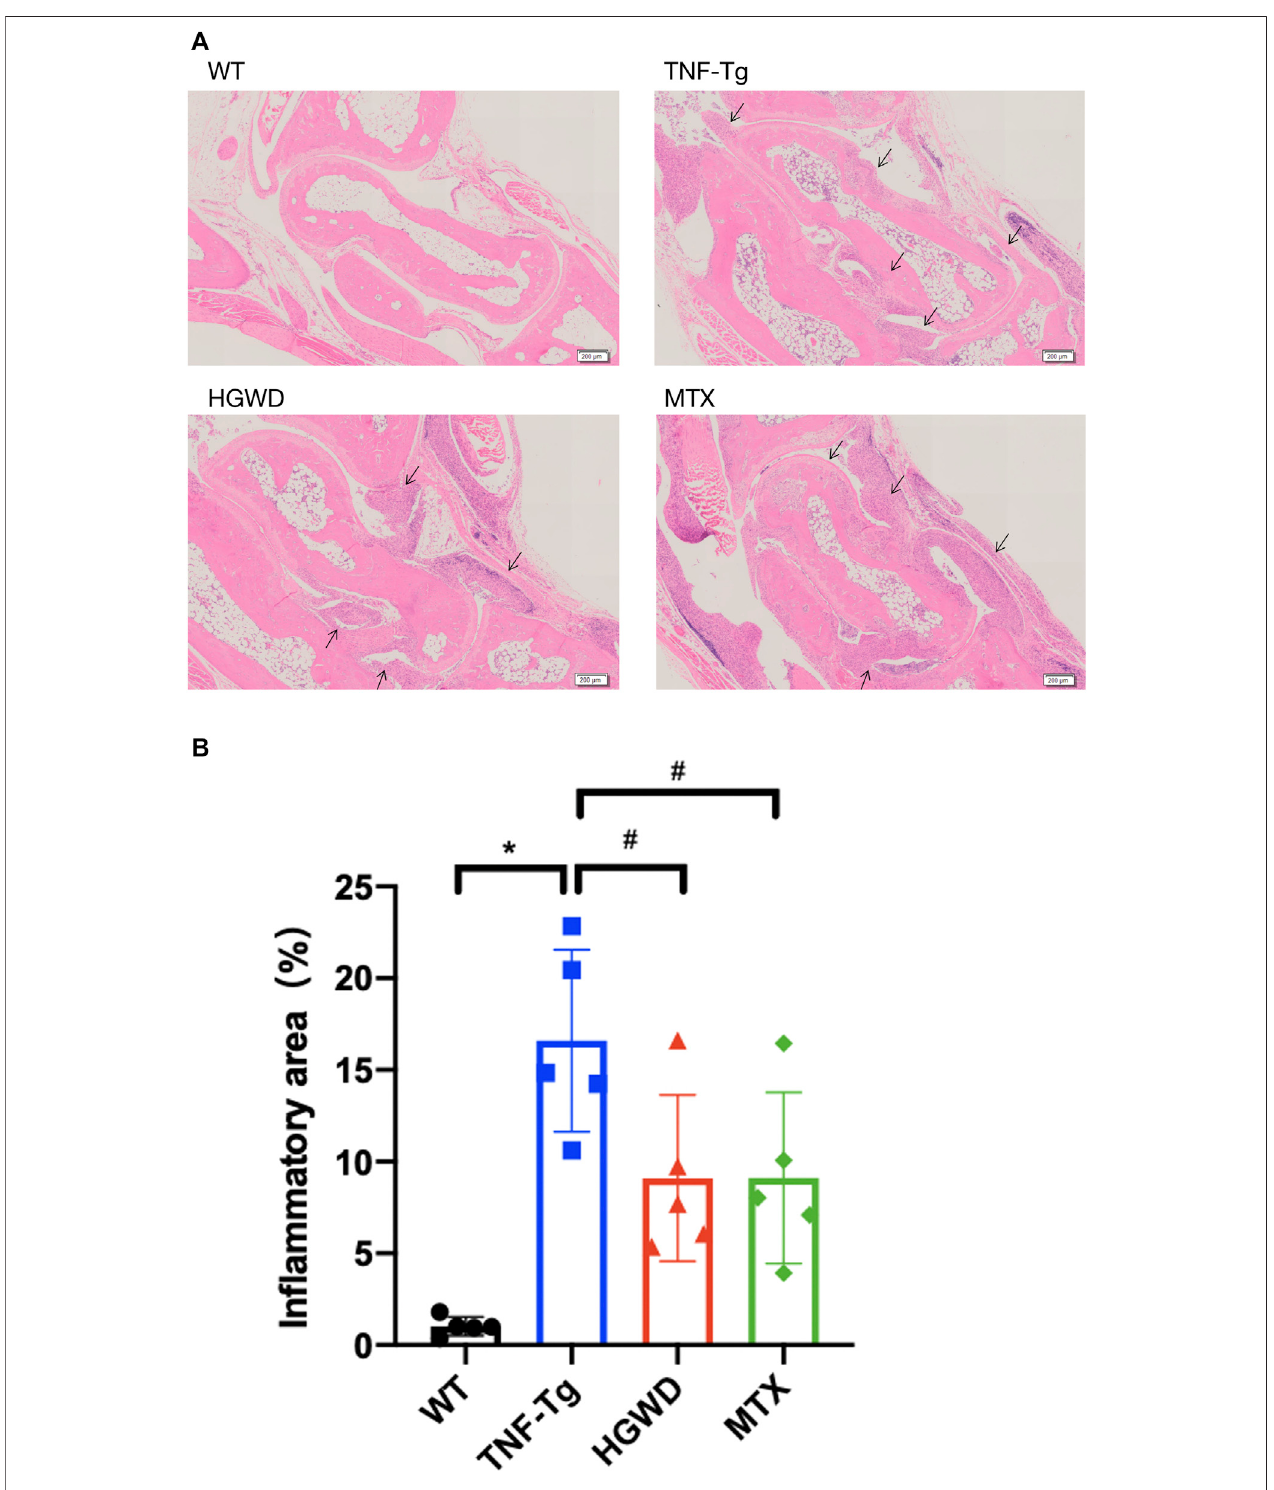
FIGURE1| HGWDalleviatesthein fi ltrationofanklejointin fl ammationinTNF-Tgmice.ThetreatmentgroupwasgavagewithHGWD,MTXwasadministeredasthe positive control group and nontransgenic littermates were used as the wild-type control group. After administration, the optimal right ankle section of each mouse was usedforHEstaining,andaslicewasselectedfromeachmouseassamplestatistics. (A) RepresentativeHEstainedsectionsshowthatthein fl ammationoftheanklejoint of HGWD-treated mice was reduced. Bar = 200 μ m, the black arrow indicates in fl ammatory synovial tissue. (B) Quanti fi cation of synovial area. The values are the mean plus or minus SD of each group of 5 legs. * p < 0.05, compared with WT group; # p < 0.05, compared with TNF-Tg group.